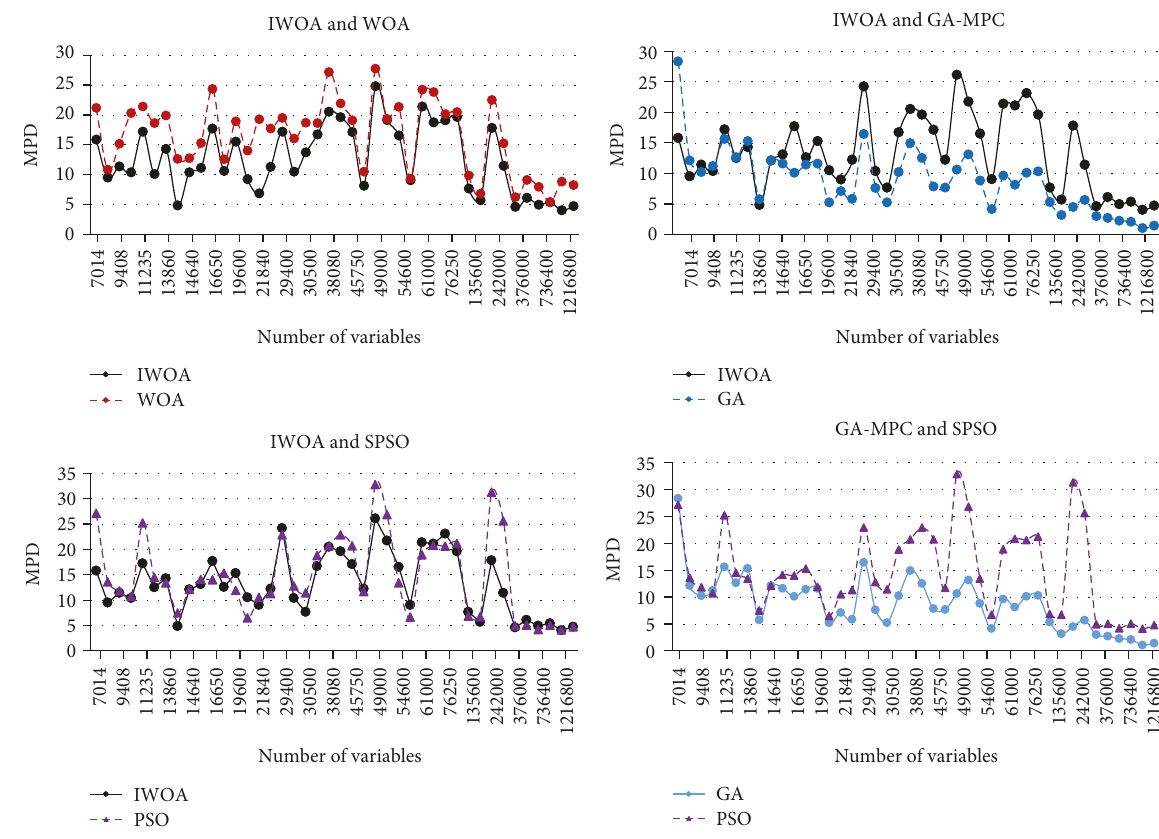
Figure 9: MPD comparison of IWOA with WOA, GA-MPC, SPSO, and GA-MPC with SPSO for large-scale instances. Table 8: Results of the one-way ANOVA test for large-scale